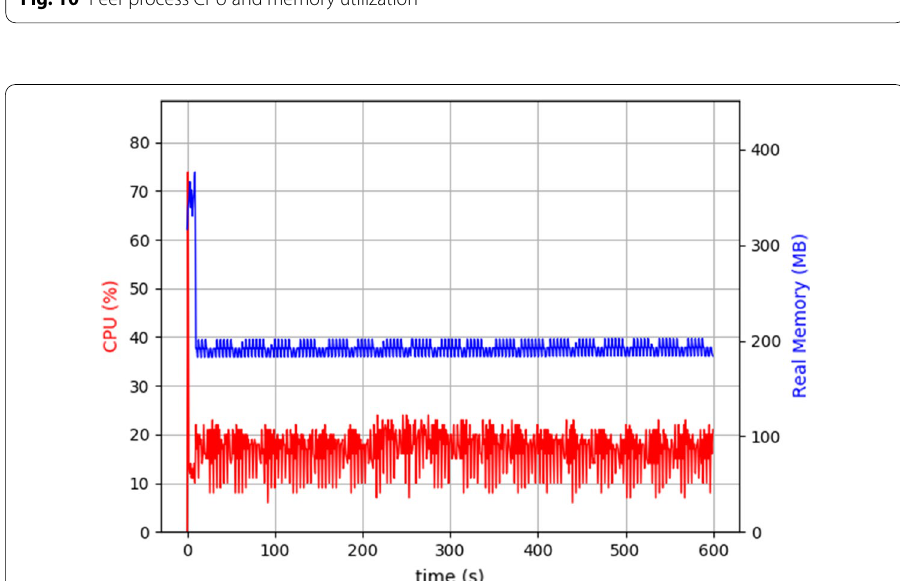
Fig. 10 Peer process CPU and memory utilization